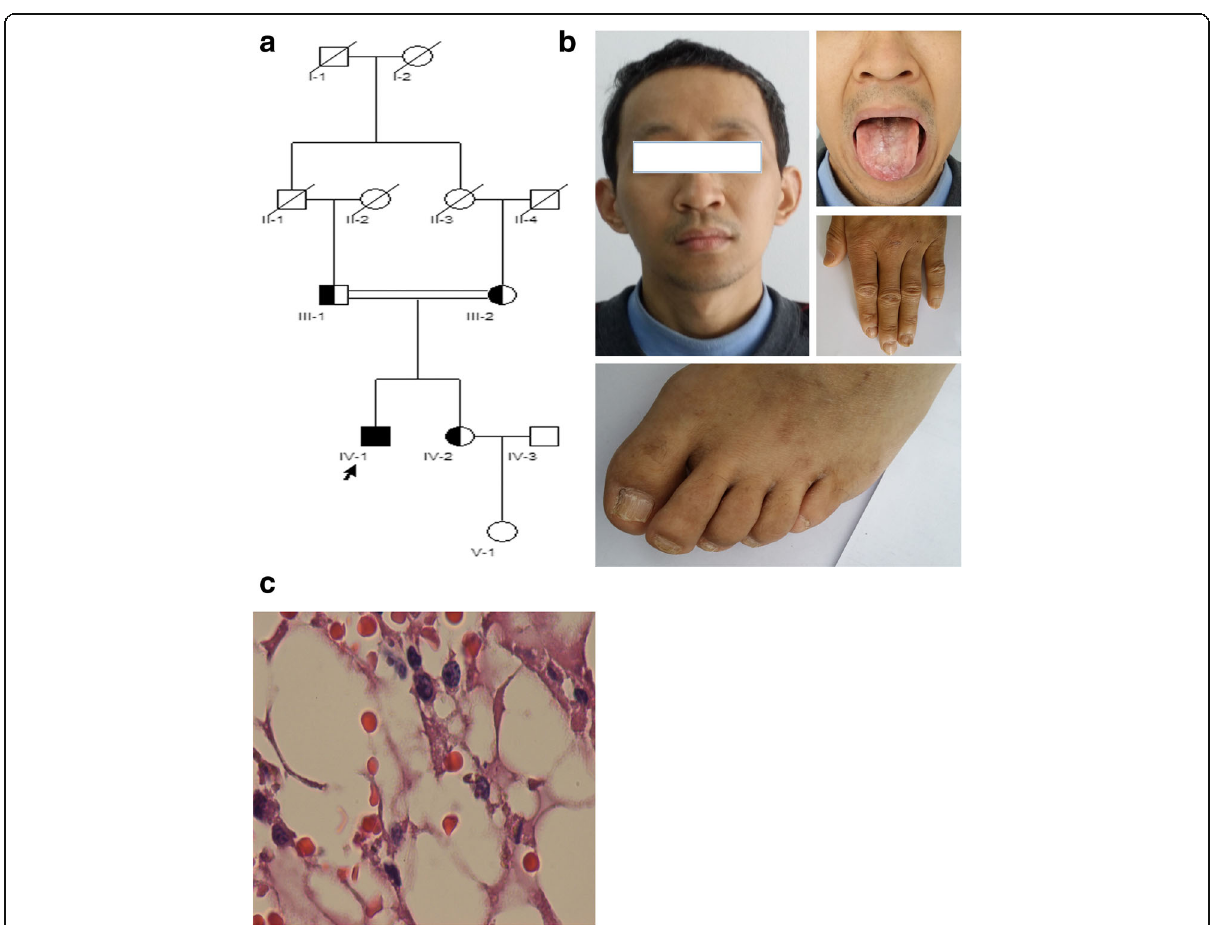
Fig. 1 a Pedigree of a Chinese family affected with DC. The arrow indicates the proband with typical clinical symptoms. His heterozygous, consanguineous parents and sister had no clinical symptoms. b The affected proband with DC showed the typical signs of nail dysplasia and oral leukoplakia. c Bone marrow biopsy of the proband revealed severe hypocellularity (HE stain, ×